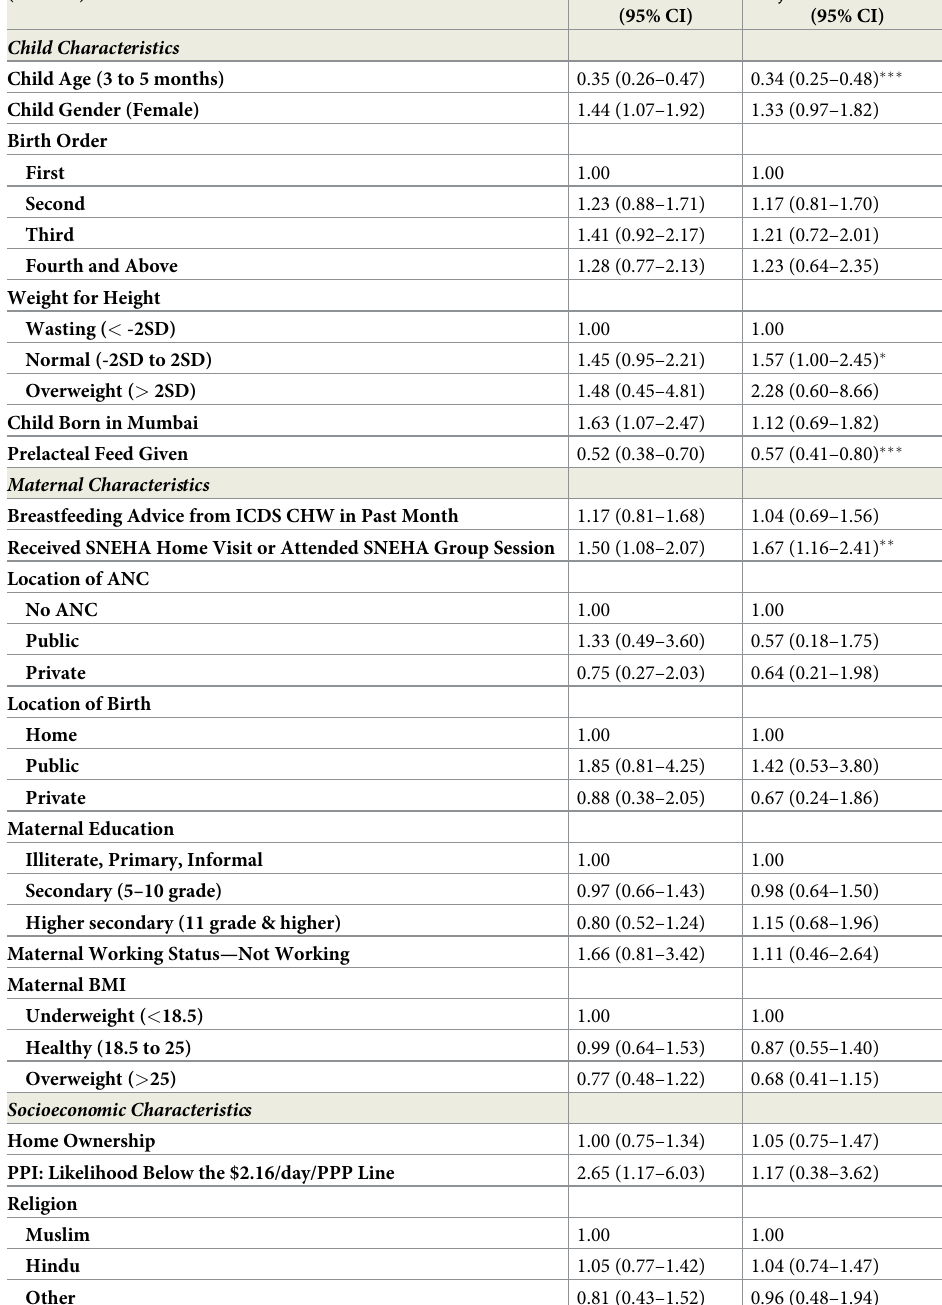
Table 2. Factors associated with exclusive breastfeeding for children under six months of age residing in informal settlements of Mumbai, India. (N =